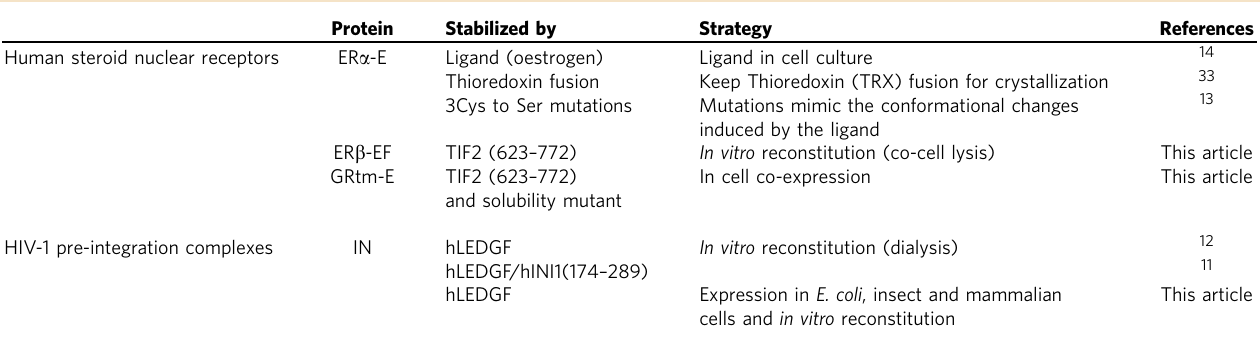
Table 1 | Proteins complexes produced using the strategy